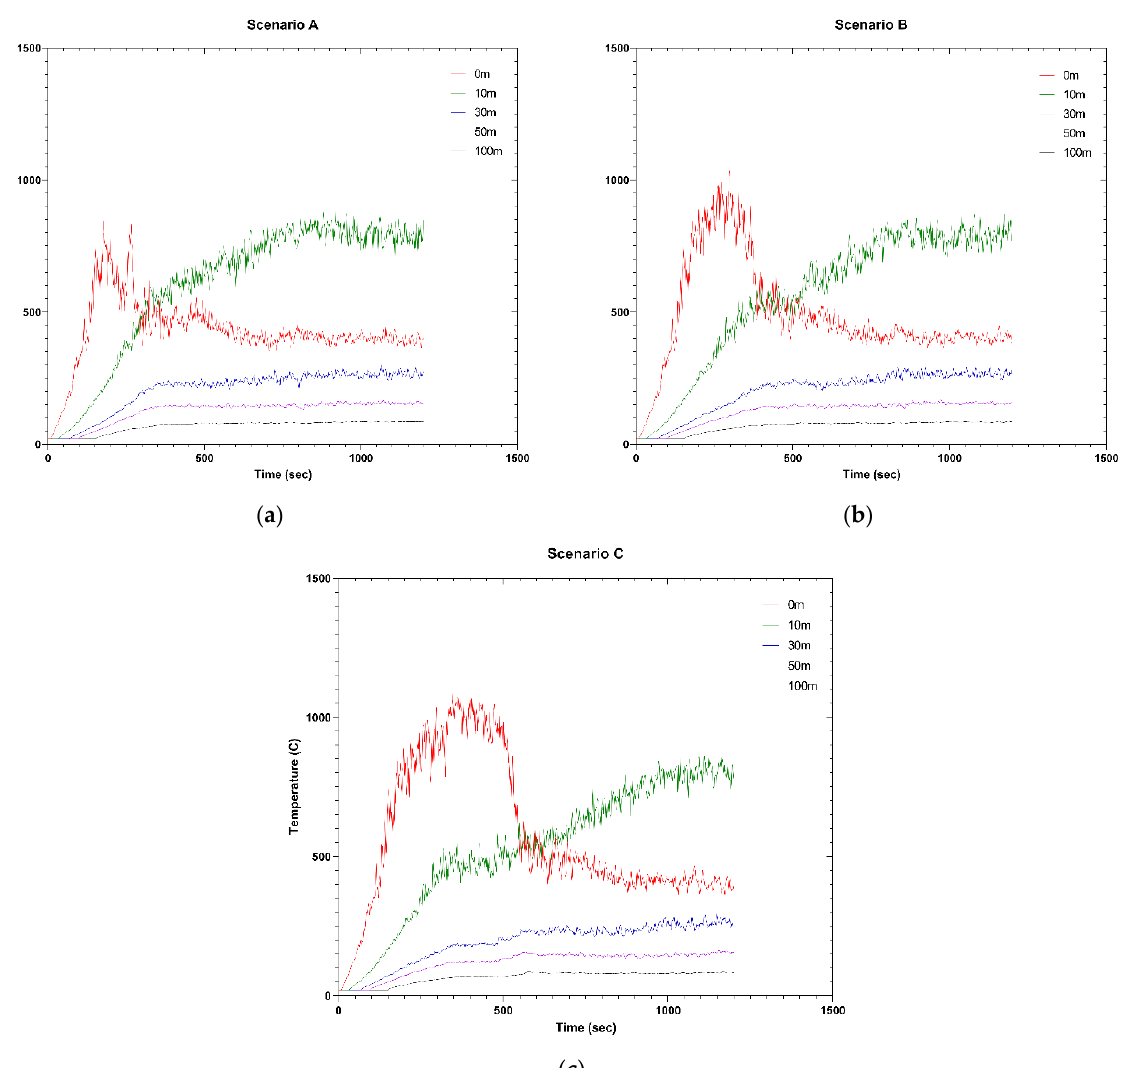
Figure 7. Tunnel ceiling (z = 7 m) gas temperature above (x = 0 m) and downwind (x = 10, 30, 50, and 100 m) from the fire source ( a ) for Scenario A, ( b ) Scenario B, and ( c ) Scenario C.